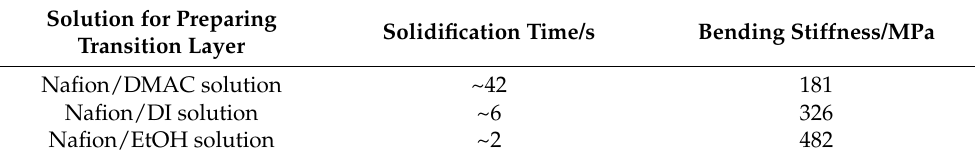
Table 1. Solidification time and bending stiffness of IPMC with different Nafion mixed solutions.